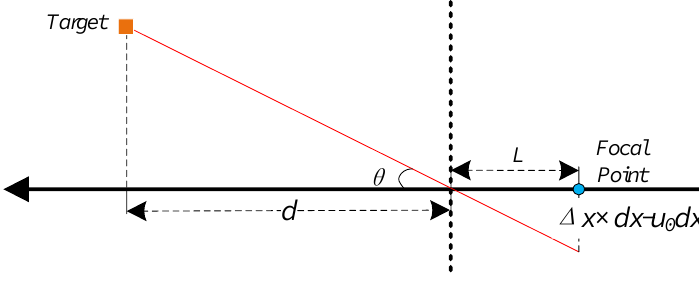
Figure 13. Iterative target tracking model. One dicyclic PID control diagram is proposed to implement iterative target tracking, as in Figure 14.For the speed controller, the greater d denotes a fartherdistance between the ASV and target.In this case, the power of the forward thruster is increased to improve